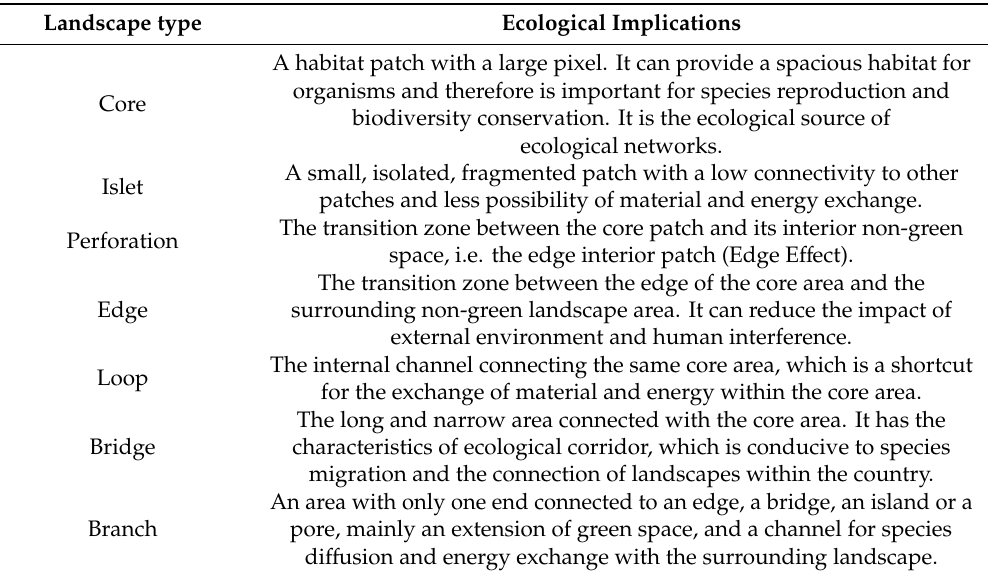
Table 2. Types and Ecological Implications of MSPA.